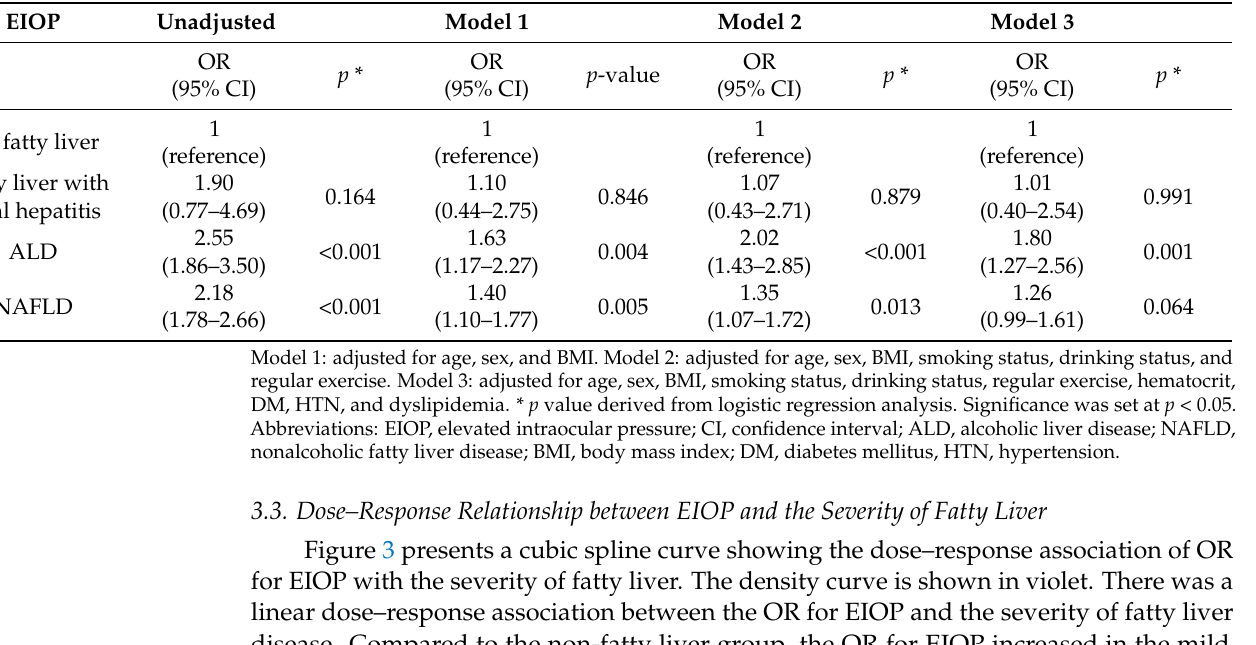
Table 3. Logistic regression analysis for the risk of elevated intraocular pressure according to the etiology of fatty